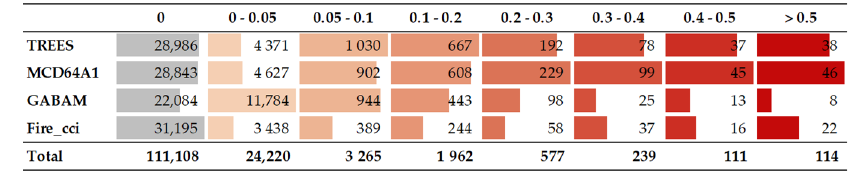
Figure 5. Burned area spatialization in a 10 km × 10 km regular grid. Each grid cell contains the burned proportion indicated by the color gradient.